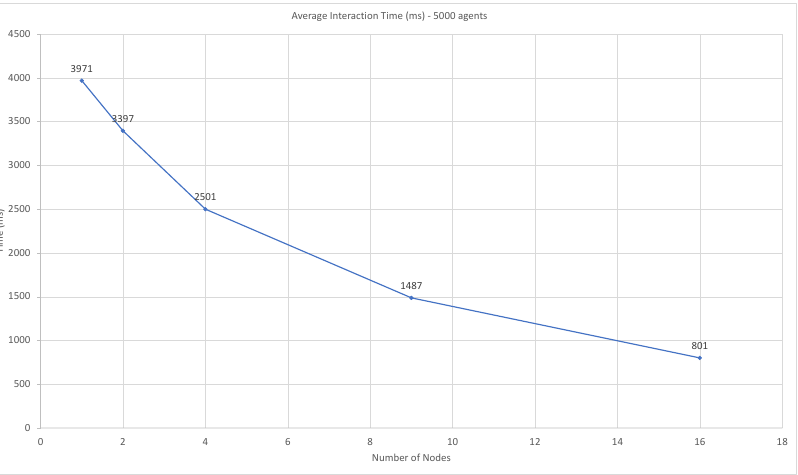
Figure 9. Interaction time (ms) for 5000 agents on 1, 4, 9, and 16 nodes, using data from Section 2.2.1 with cellular morphology